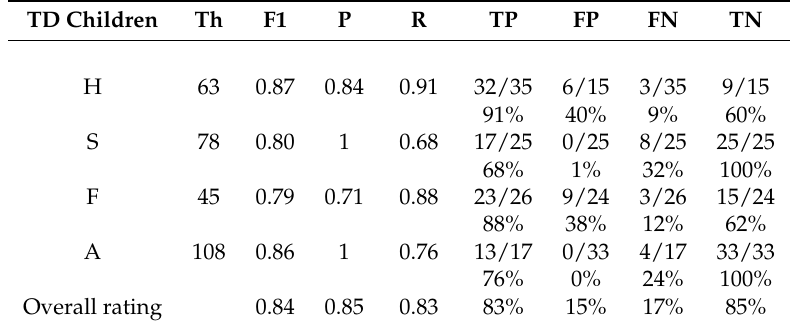
Table 8. Accuracy of the automatic system with respect to manual annotations for TD children when the best decision threshold (in terms of F1-score) for each expression was